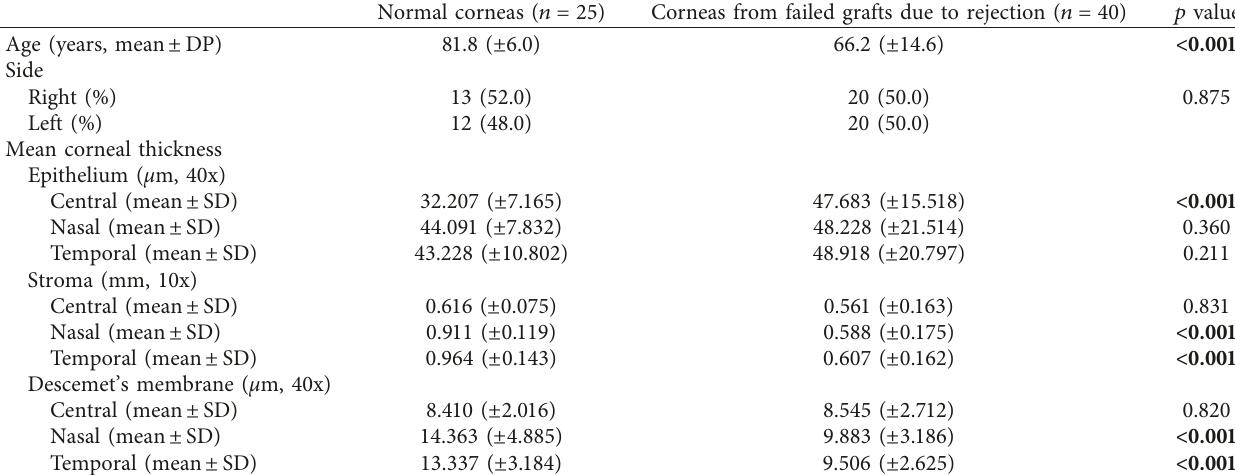
Table 1: Comparison of the ages, sides, and measurements of the layers obtained by digital microscopy between normal corneas and corneas from failed grafts due to